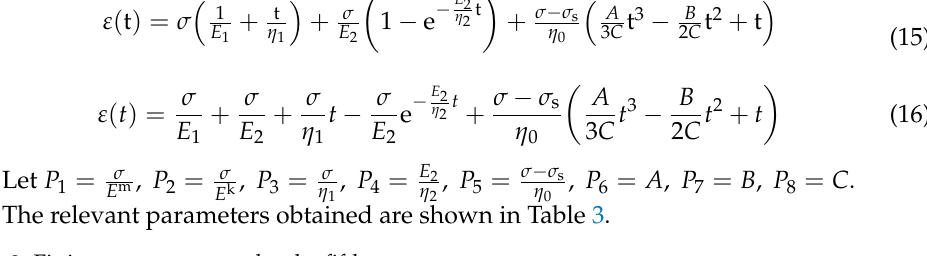
Table 3. Fitting parameters under the fifth stress.